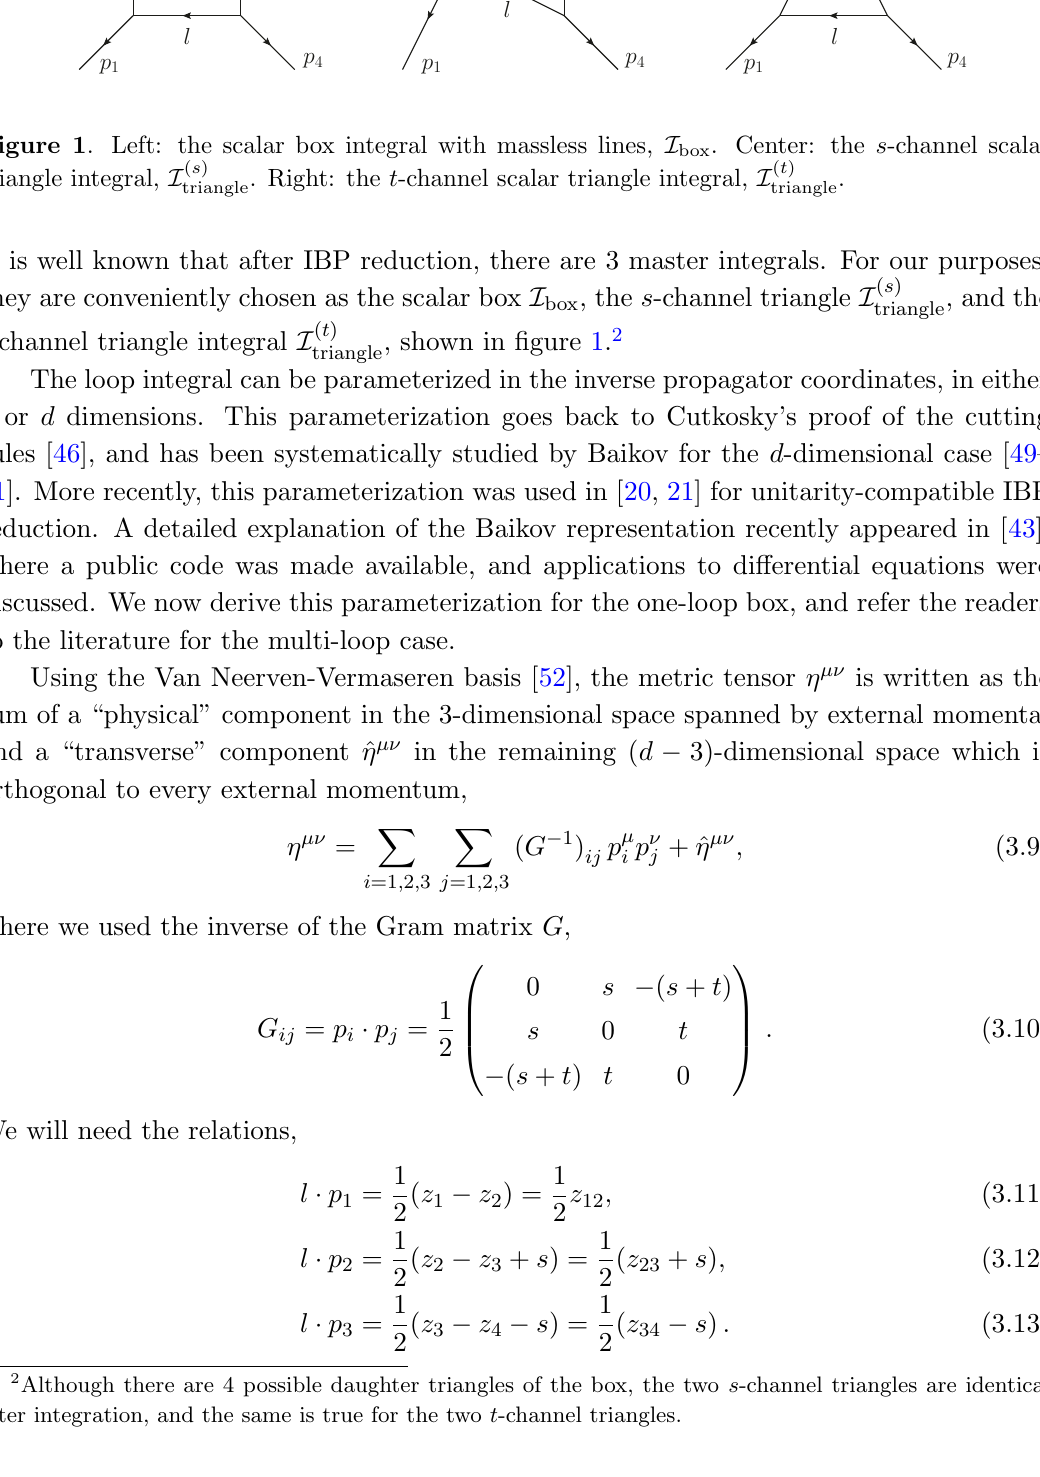
Figure 1 . Left: the scalar box integral with massless lines, triangle integral, It is well known that after IBP reduction, there are 3 master integrals. For our purposes, they are conveniently chosen as the scalar box t -channel triangle integral